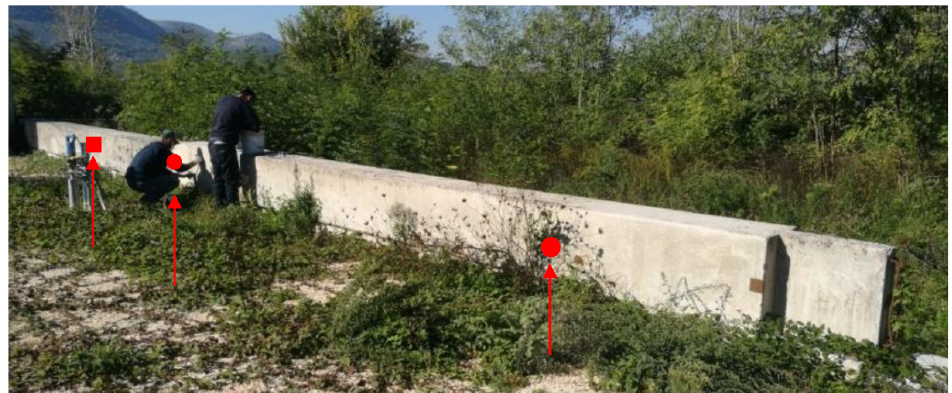
Figure 1. Precast RC squared column “C”; red circles show the location of coring sites; the red square shows the location of the extraction site of the parallelepiped-shaped diamond-cut sample.